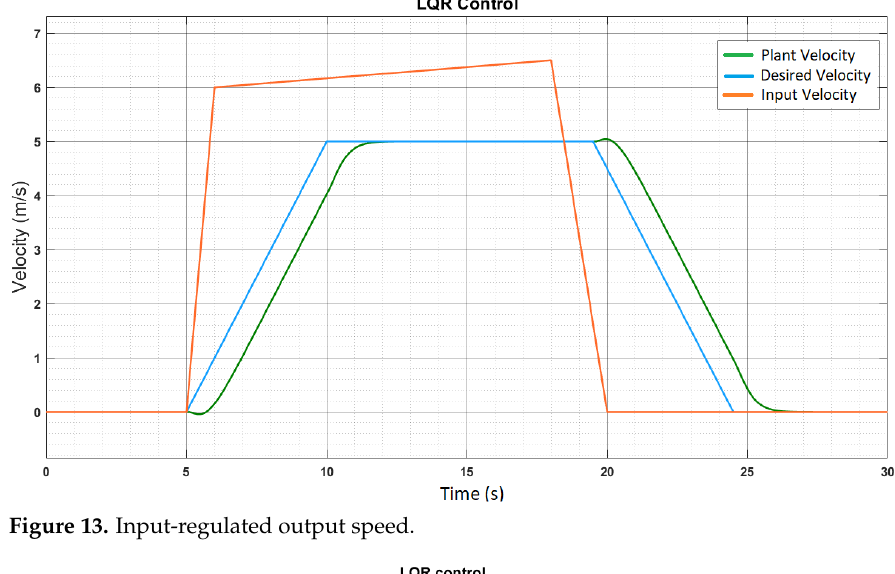
Figure 13. Input-regulated output speed.